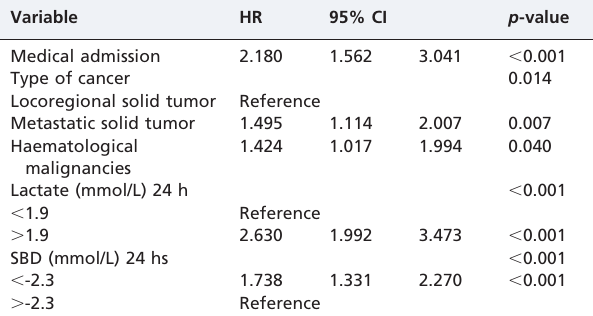
Table 4 - Multivariate Cox proportional hazard analysis with hospital mortality as the dependent